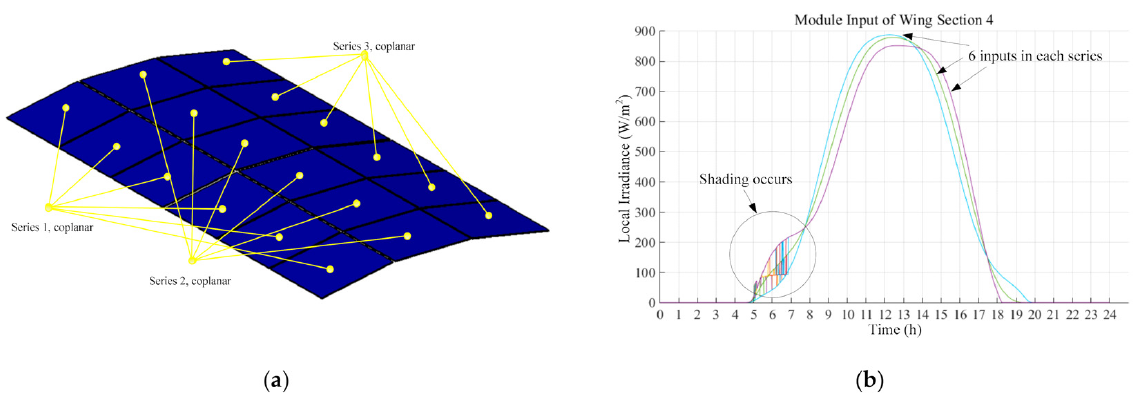
Figure 8. Irradiation inputs to PV modules. ( a ) PV modules on airfoil curve. ( b ) Irradiation inputs of wing section 4.